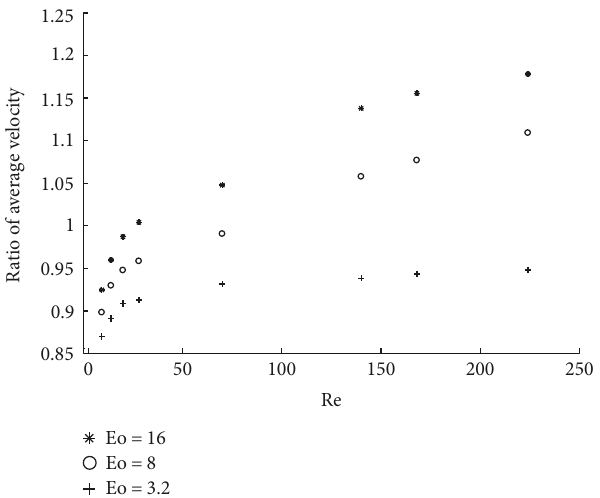
Figure 10: Relationship between the ratio of average velocity and Re and